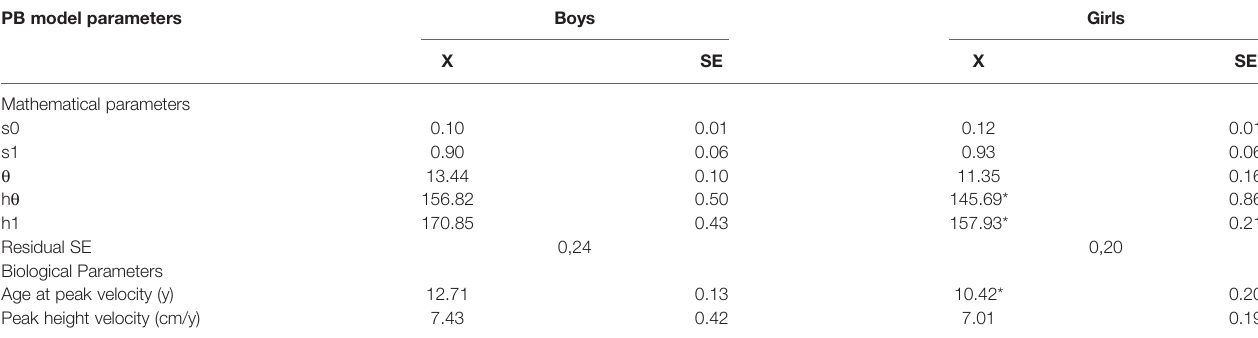
TABLE 2 | Mathematical and biological parameters of stature, estimated by 1Preece-Baines (1PB) model. PB model parameters